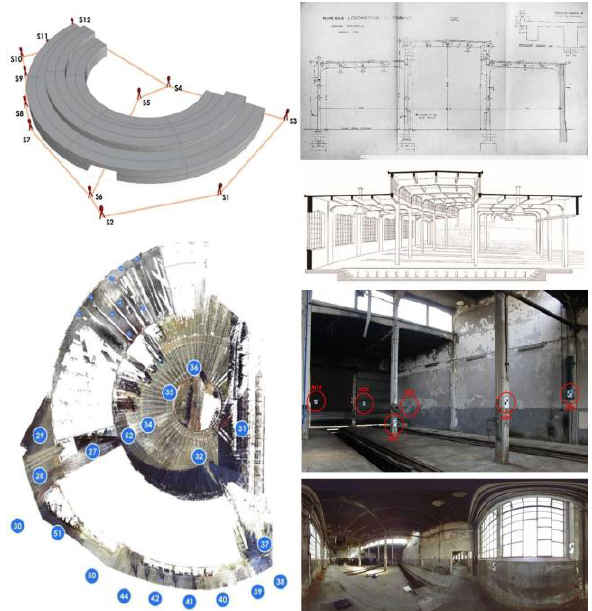
Figure 3. From the project survey up to the indirect acquisition and archival researches